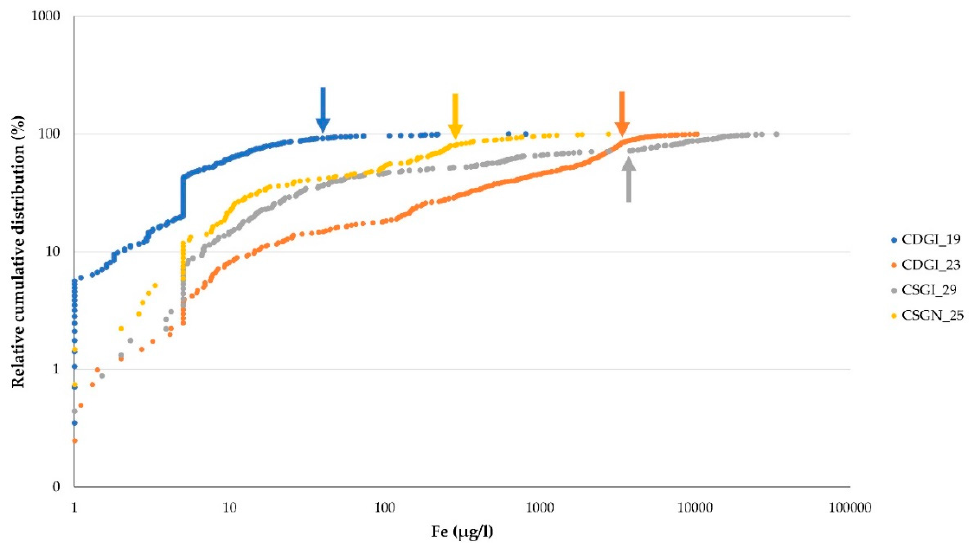
Figure 7. Cumulative relative frequencies of iron (Fe) for analysed groundwater bodies. Arrow indicates value x considered for the calculation of Mean + 2SD and Median + 2MAD ranges for each groundwater body.